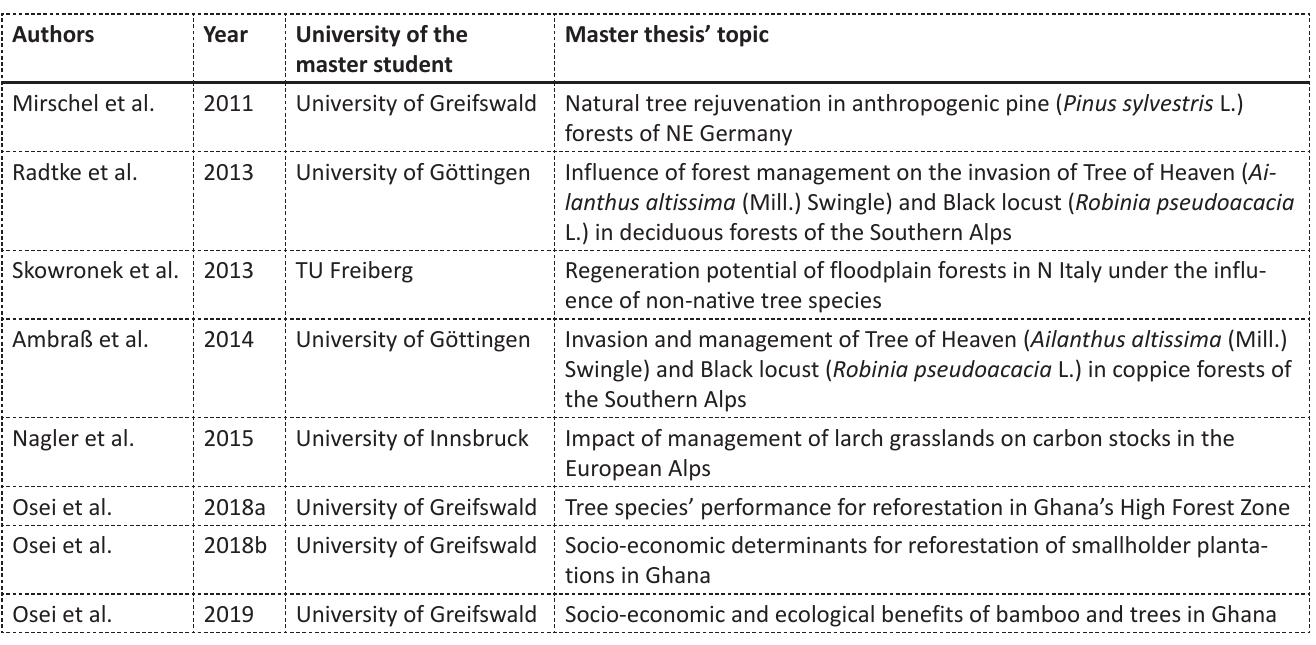
Table 3: Master theses integrated into the study-abroad program, which were published by the research team; order according to publication